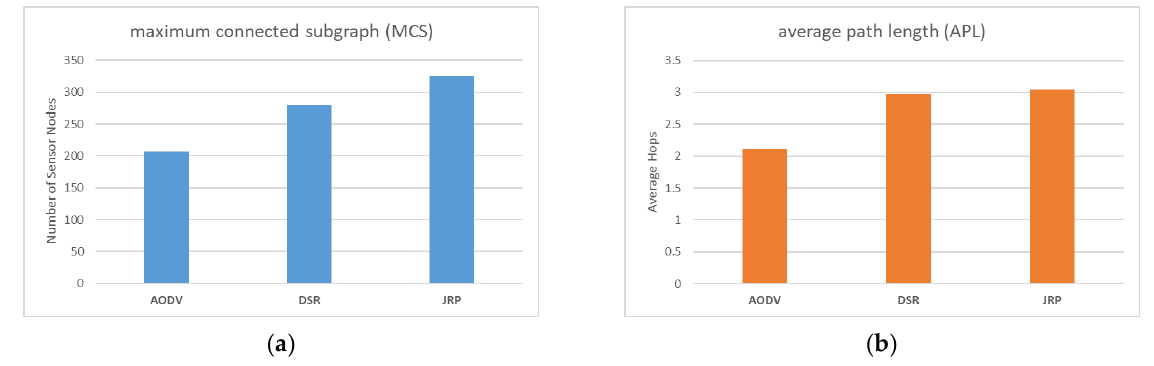
Figure 12. ( a ) Comparison of MCS with different protocols; ( b ) Comparison of APL with different protocols.